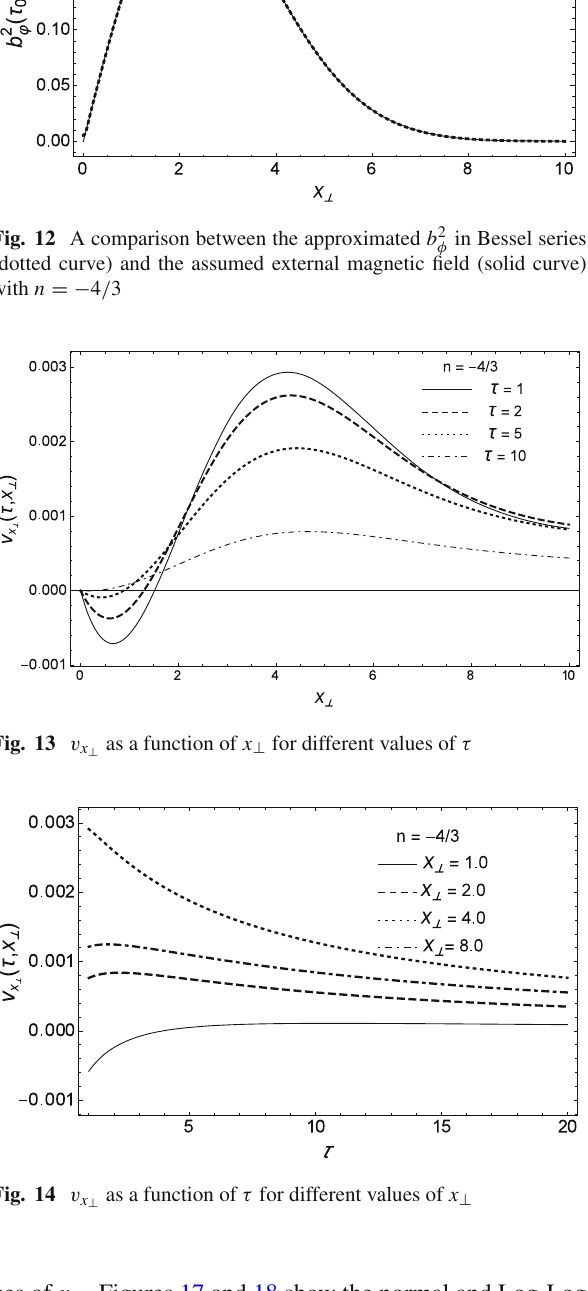
ues of x ⊥ . Figures 17 and 18 show the normal and Log-Log plots of the total (cid:5)(τ, x ⊥ ) as a function of τ for several val- ues of x ⊥ , respectively. In Fig. 15, we find that for x ⊥ = 0 the correction energy density is always positive and then it decreases from the value at x ⊥ = 0 with increasing x ⊥ . From Fig. 16 one also finds that for the case n = − 4 / 3 the correc- tion energy density is always positive, at variance with